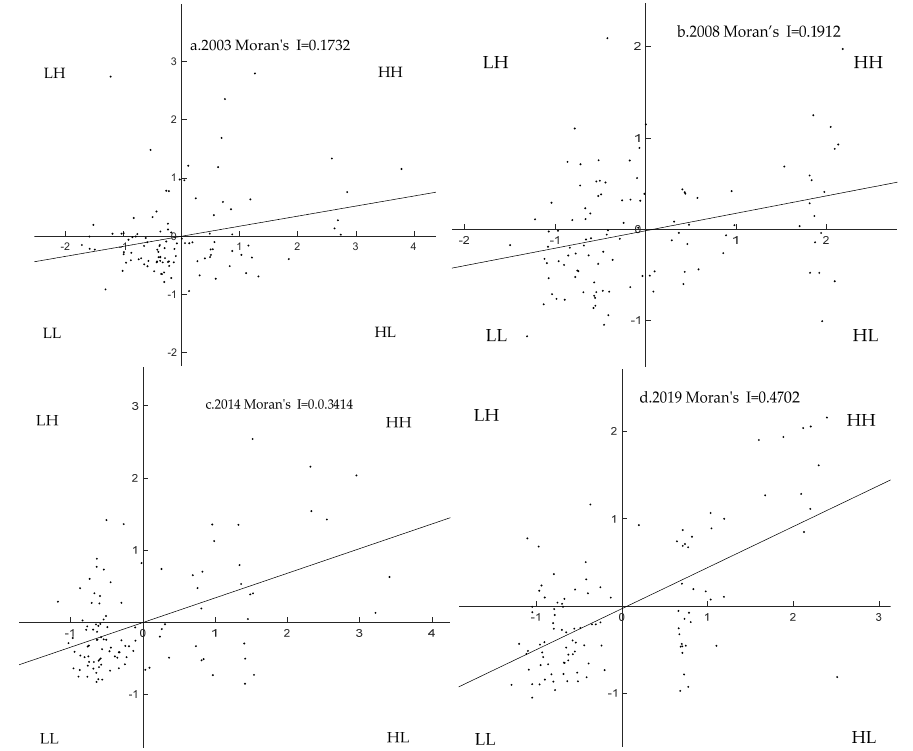
Figure 5. Local Moran scatter plot of ULUE in the Yangtze River Economic Zone. ( a ) Moran’s I in 2003; ( b ) Moran’s I in 2008; ( c ) Moran’s I in 2014; ( d ) Moran’s I in 2019.